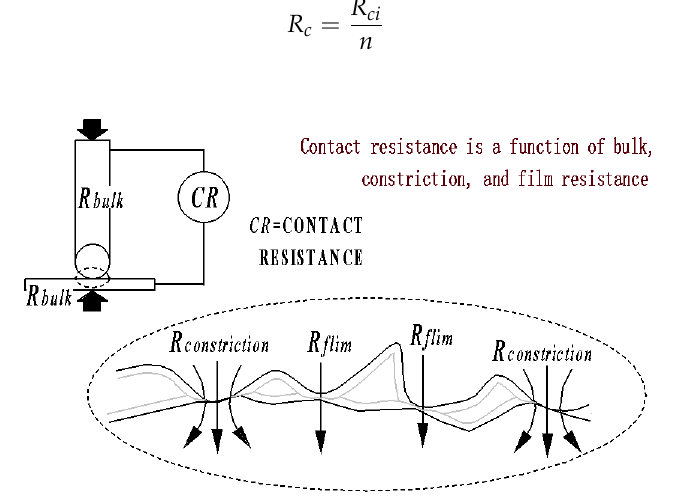
Figure 19. Schematic representation of contact resistance. and the bulk resistance of the pad